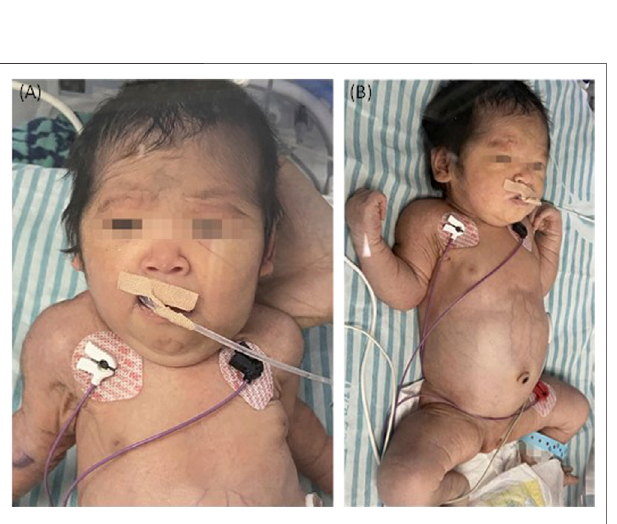
FIGURE 3 | The TALDO-de fi cient dysmorphic feature-hirsutism (forehead), low hair implantation, mild pallor, and cuties laxa with visible vascularnetworkofthepatient.Theabdomenwasalsogrosslydistendedwith dilated visible veins [ (A) frontal view, (B) side